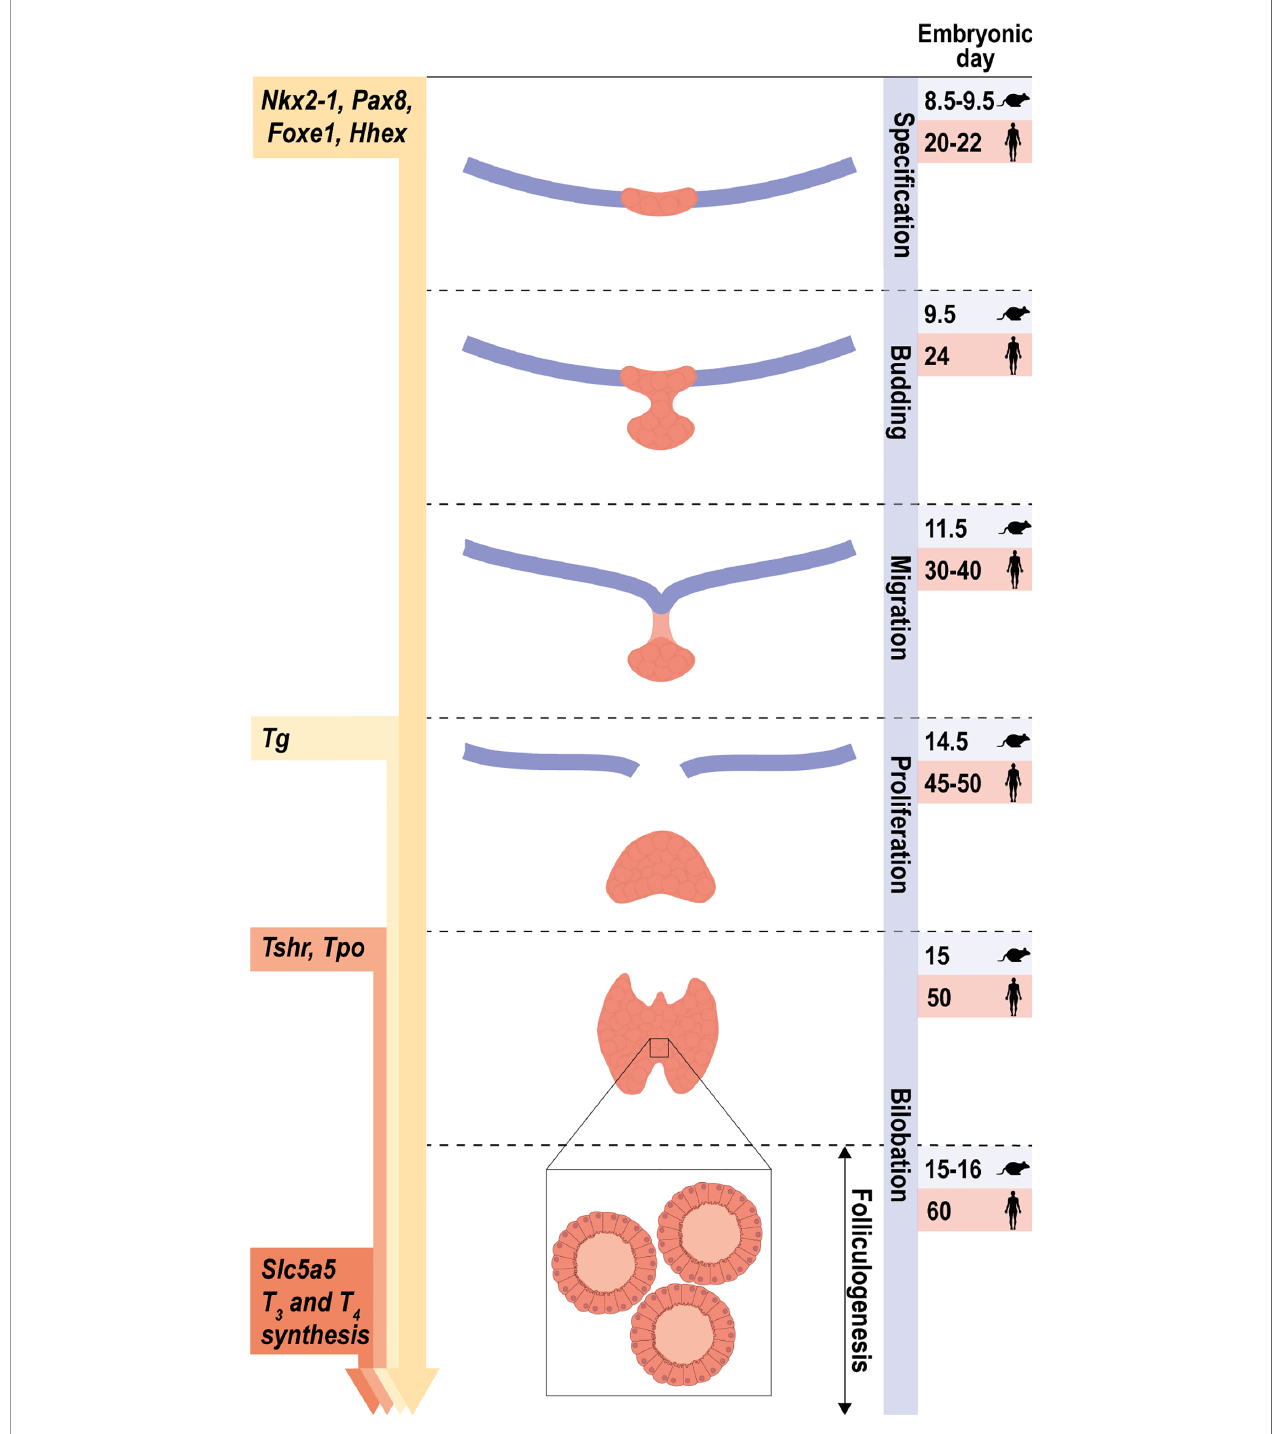
FIGURE 1 | Stages of early thyroid development. Schematic representation of the main steps of thyroid morphogenesis indicating the corresponding embryonic or post-fertilization day in mice and humans, respectively. From an undifferentiated endoderm, the co-expression of Nkx2-1 , Foxe1 , Pax8 and Hhex de fi nes the speci fi cation of thyroid progenitor cells. Arrows on the left represent the initial stage at which the expression of the thyroid transcription factors and their main target genes are fi rst detected. The onset of thyroid hormone synthesis and Slc5a5 expression occurs at the fi nal stage, once folliculogenesis has occurred and the thyroid gland is completely